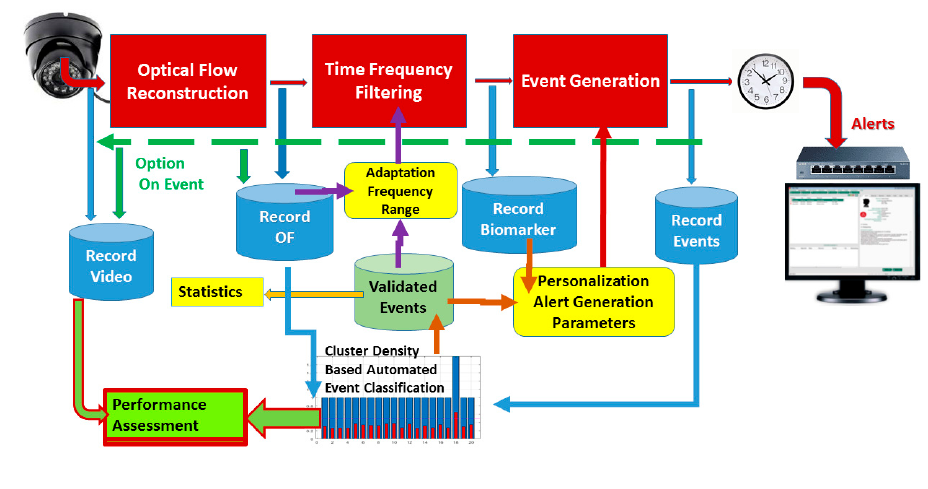
Figure 1. Overall processing flow of the proposed seizure detection and alerting system. USB day/night camera delivers fixed frame rate video stream to a PC platform. Optical flow algorithm for reconstruction of group parameter velocities and a set of Gabor wavelet decomposition and